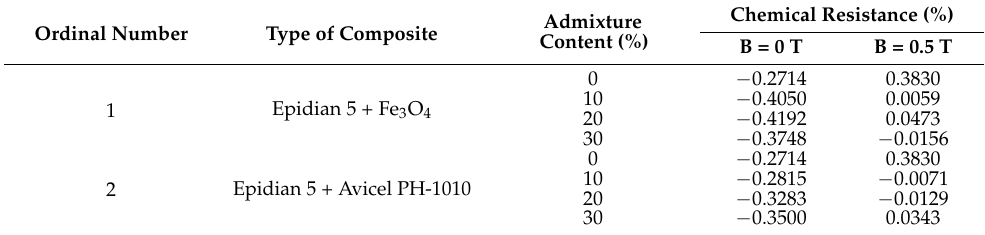
Table 19. Chemical resistance to alkali